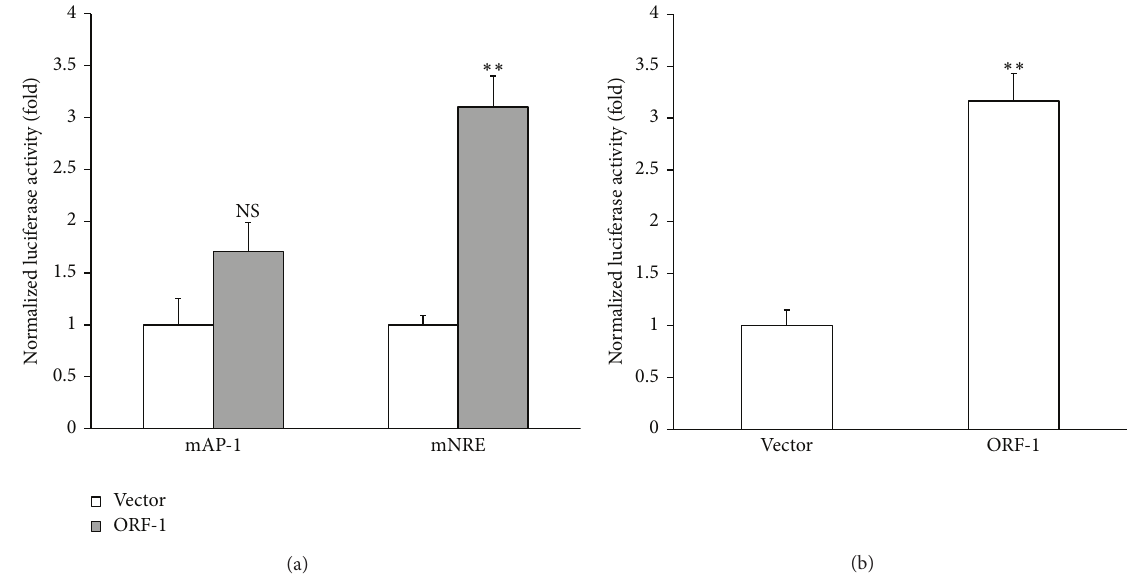
Figure 3: AP-1 is involved in CXCL-8 activation by HEV ORF-1. HuH-7 cells were cotransfected with plasmid vector or a plasmid expressing HEV ORF-1 protein, together with − 173 mAP-1 or mNRE CXCL-8 promoter-luciferase reporters (a) or a luciferase reporter with seven repeats of the AP-1 binding sequences (b). Luciferase assay was performed 48 hours after transfection. Luciferase activity was normalized against the protein concentration of the same samples. ∗∗ : p ≤ 0.01; NS: not significant by Student’s t -test.